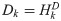
Density of DIMPs around transcription start and end sites.In each graphic the bases at position zero denote the centers of the 3’ (left) and 5’ (right) untranslated regions. The DMPs are estimates for the 30th generation lines: L29 and L119 (replicates 1 and 2) in respect to 3rd generation lines: L1 and L12 from reference [19]. Fisher exact test and the corresponding particular cases of Eq 30 (DR = Dk) for information (Eq 3, Dk = Ik), Total variation (Eq 25, Dk = TVk), Kullback–Leibler (Eq 26, Dk = KLk) and Hellinger (Dk=HkD, Eq 27) divergences were used in the estimation of DMPs without distinction between methylation contexts. The density of DIMPs based on the absolute difference of methylation levels (which is equal to TV) was estimated based on Fisher exact test (TV (Fisher test)) and on the CDF for TV according to Eq 30 (Dk = TVk). DMPs estimated by the “classical” methods can be overestimated or underestimated. Any method to estimate DMPs must take into consideration the statistical-biophysical nature of the methylation process at tissue or organ levels. Every sample follow an independent ontogenetic development and the action of the omnipresent thermal fluctuations on cells and tissues leads to different methylation profiles.